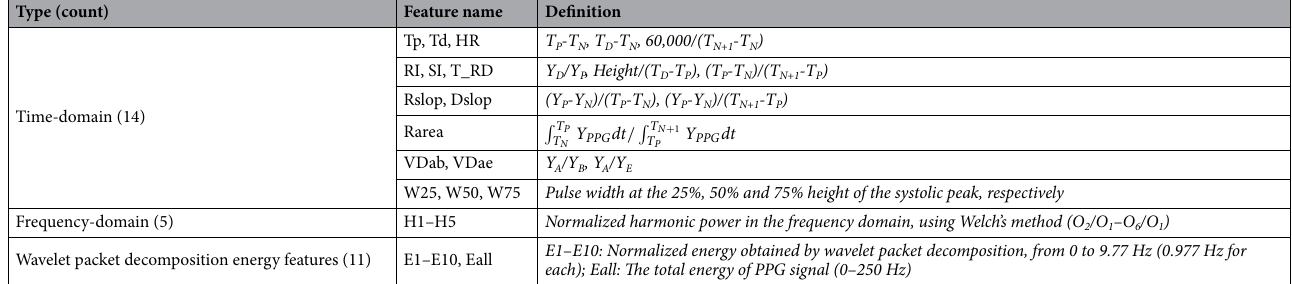
Table 1. Definition of extracted features from PPG and